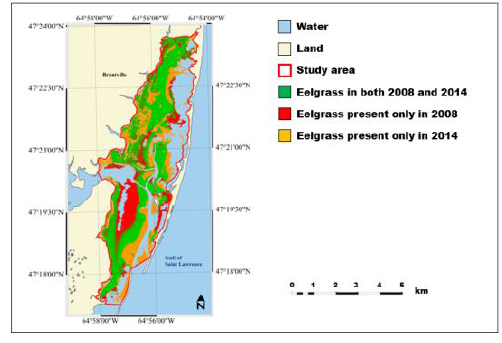
Figure 6. Comparison of the eelgrass extent between 2008 and